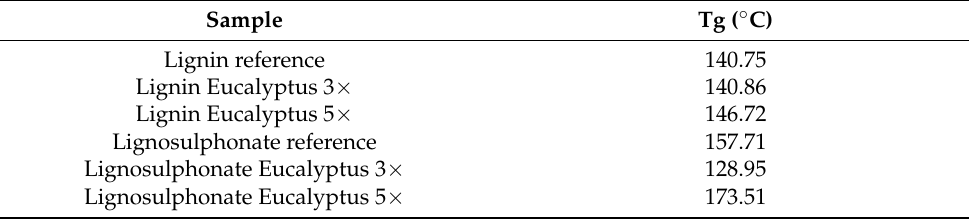
Table 4. Tg value of lignin and lignosulphonate.